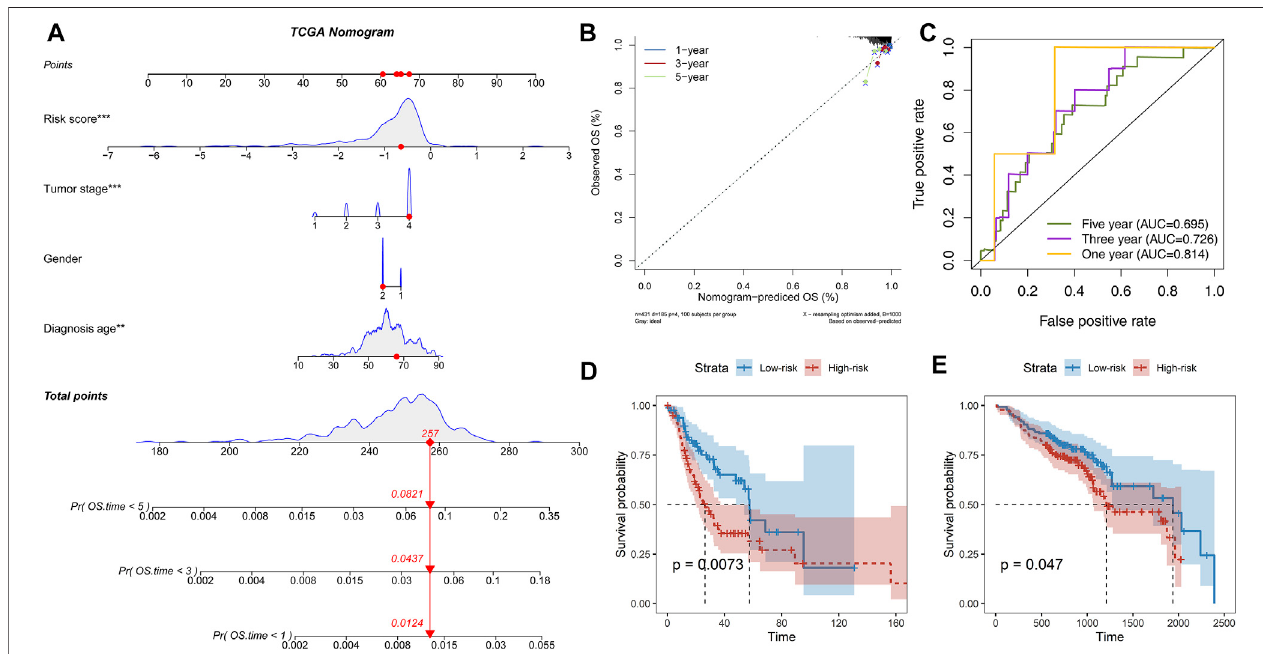
FIGURE3| PFLSwasanindependentprognosisfactorinHNSCC. (A) Nomogramcomposedofage,gender,stage,andriskscoreforthepredictionof1-,3-,and 5-yearsOSprobability. (B) CalibrationforassessingtheconsistencybetweenthepredictedandtheactualOSat1,3,and5years. (C) ROCcurvesatone,three,and fi ve years were applied to verify the prognostic performance of the PFLS in the TCGA training set. D-E. The Kaplan – Meier curve of HNSCC cancer samples strati fi ed by the risk group with the log-rank test p -value provided in (D) TCGA test set and (E) GSE65858.